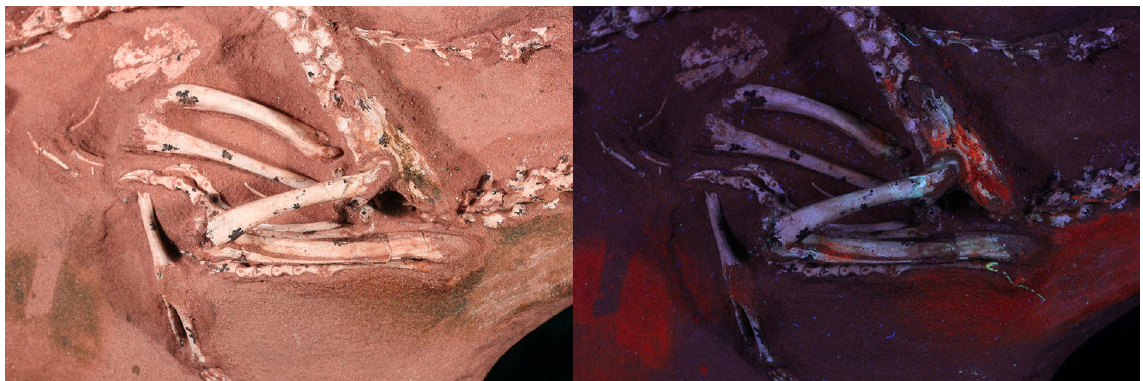
Fig. 4.5. Detail of the Halszkaraptor fossil from Mongolia. In white light on the left, in UV fluorescence on the right. The UV fluorescence image displays restorations of the fossils and treatment applied to preserve